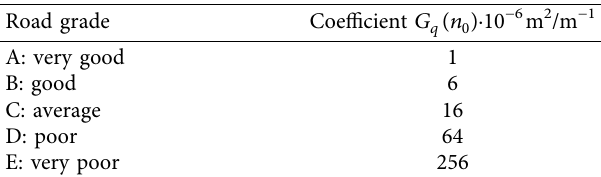
Table 2: Road roughness